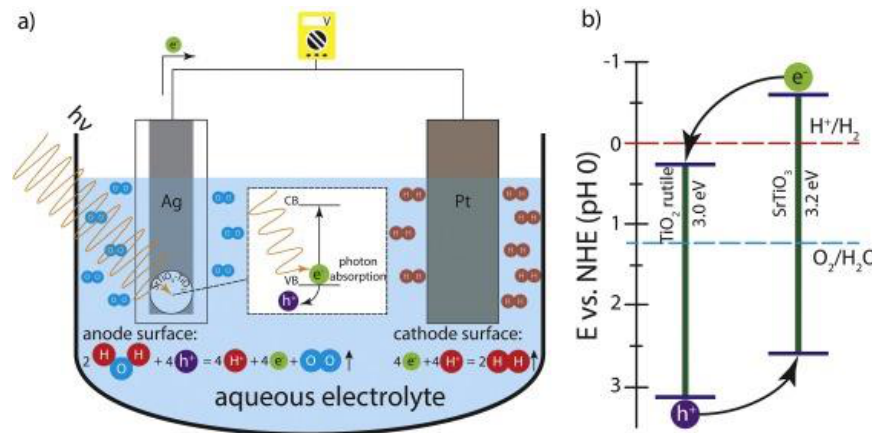
Figure 9. SrTiO 3 –TiO 2 eutectic composite-based PEC cell. ( a ) A simplified PEC cell employing a eutectic system as the photoactive anode material. ( b ) Charge-carrier separation mechanism at the phase boundary, with bandgap positions and values with respect to electrochemical potential (E) vs.